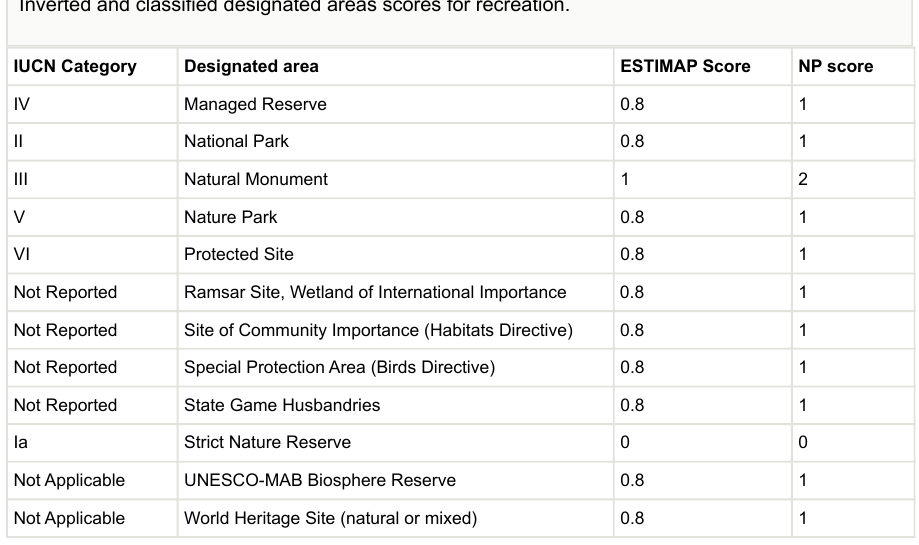
Inverted and classified designated areas scores for